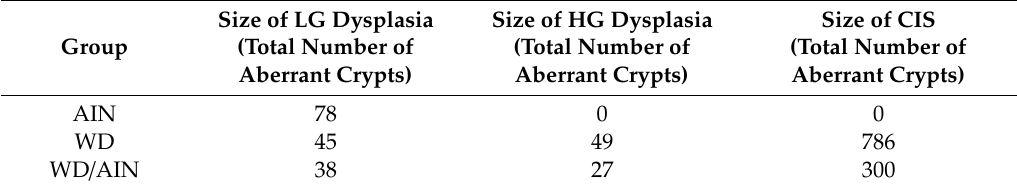
Table 2. E ff ect of the diet on the size of LG and HG dysplasias and of CIS. Size of LG Dysplasia Size of HG Dysplasia Size of CIS Group (Total Number of (Total Number of (Total Number of Aberrant Crypts) Aberrant Crypts) Aberrant Crypts) AIN 78 0 0 WD 45 49 786 WD / AIN 38 27